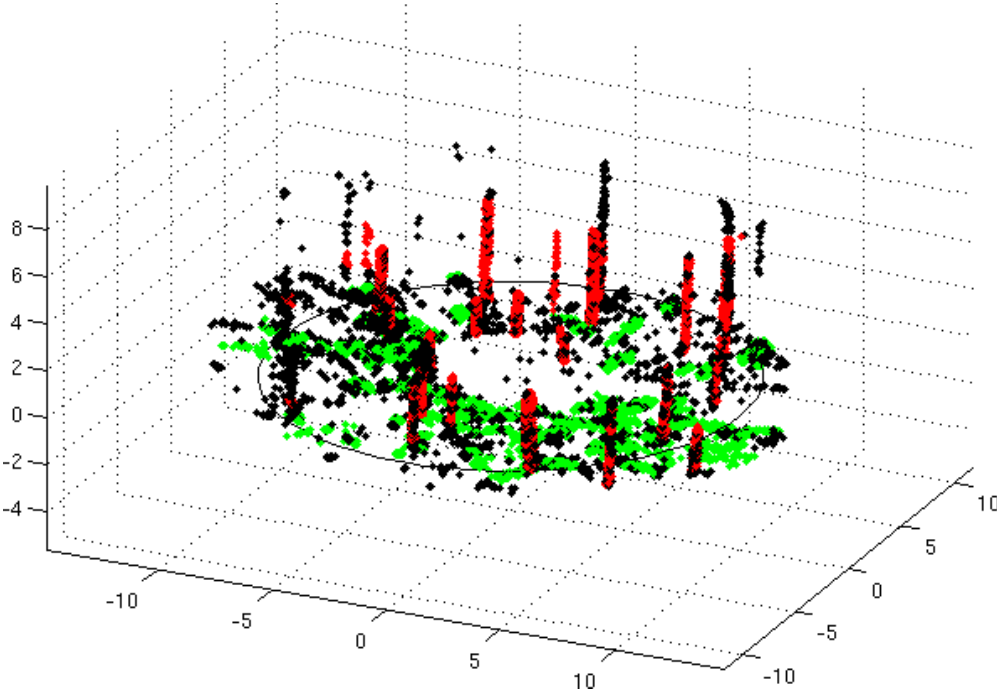
Figure 7. Green points are segmented as ground points, red points as stem points, and black points are neither. The point cloud is cropped at 12 m from the center and contains approximately 30,000